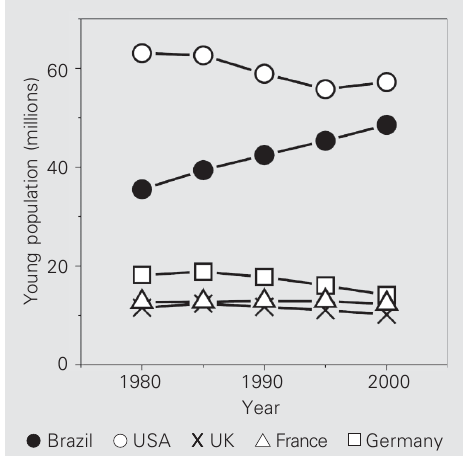
Figure 2. Young population. Number of 18- to